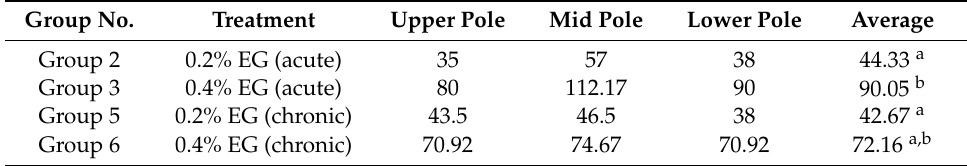
Table 4. Stone values of X-rats kidney tissue with ethylene glycol (EG) concentration. Group No.